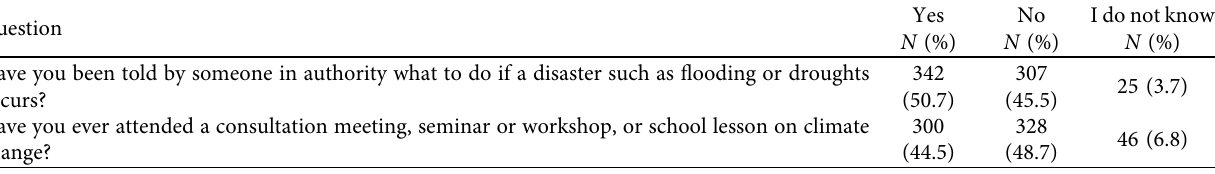
Table 9: Guidance and training on climate change